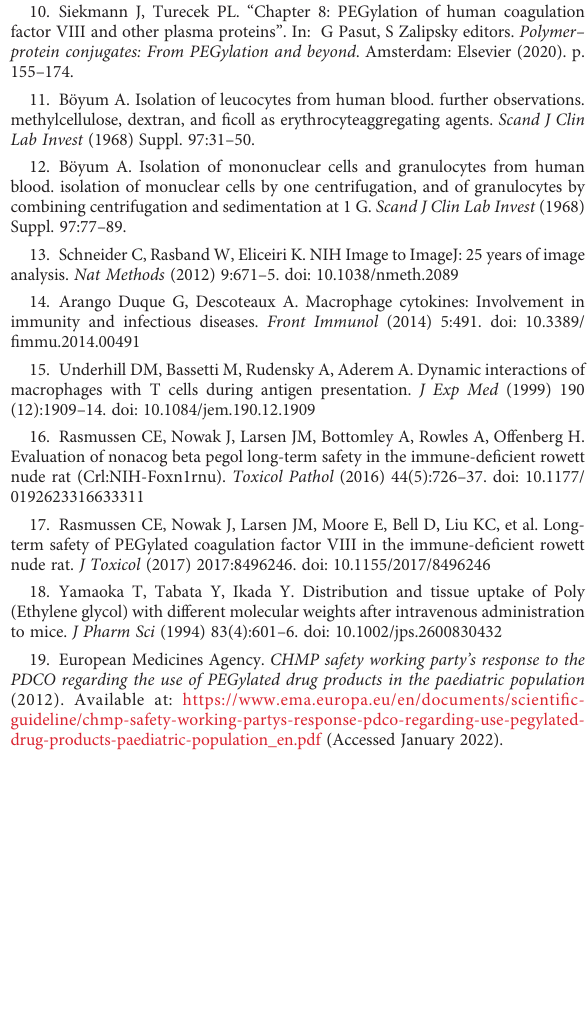
SUPPLEMENTARY FIGURE 1 Semi-quantitative Analysis of Vacuolation. Semi-thin sections of MDMs exposed to PEG for 24 h were analyzed with light microscopy. This fi gure shows a representative image from one sample, demonstrating semi-quantitative analysis (magni fi cation:63x). White dot: marks single MDM; colored dots/circles de fi ne different vacuolation stages; green dotted = stage (A) : 1 to 3 small vacuoles in a single MDM; magenta